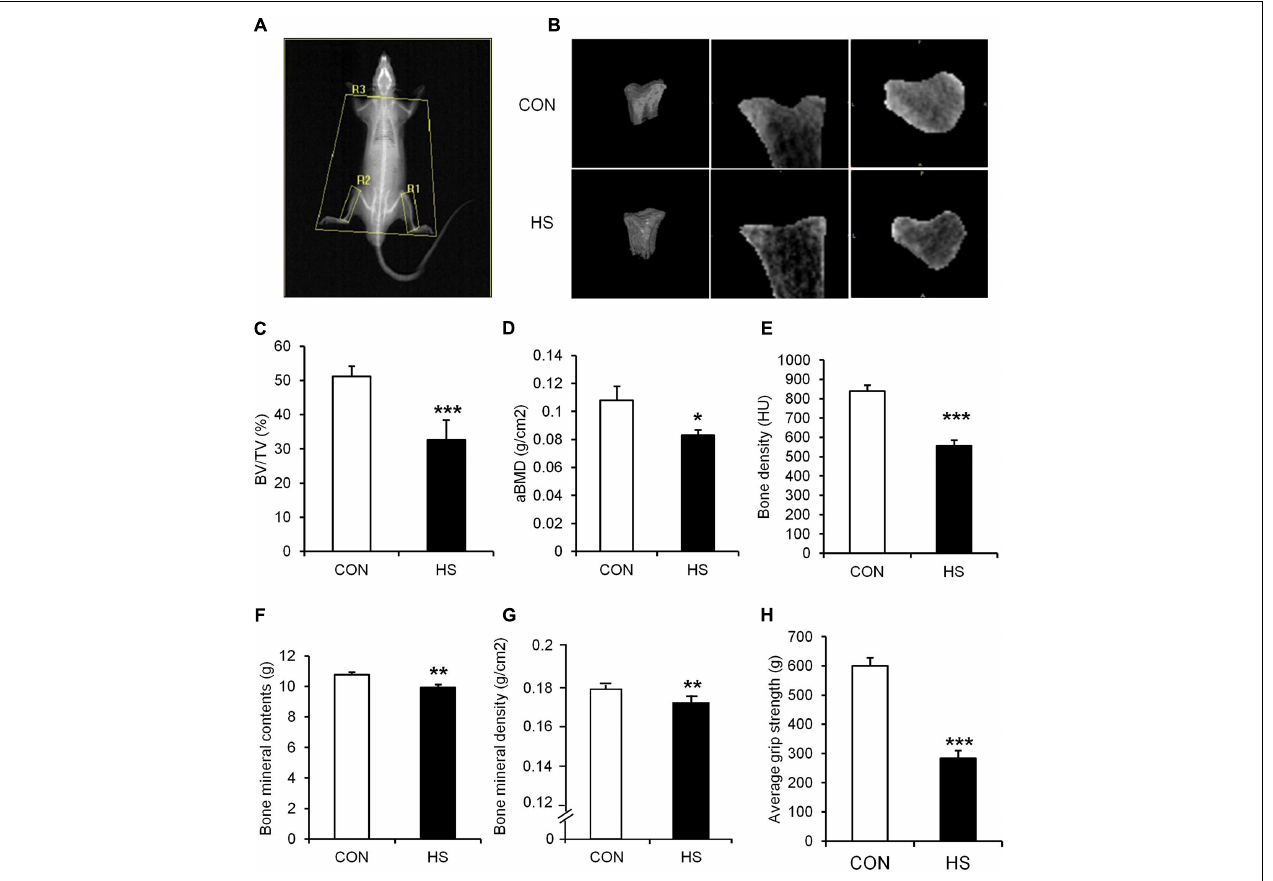
FIGURE 2 | The effects of hindlimb suspension on bone morphology and grip strength. (A) Image of ROI area selection of DXA scan (R1, right tibia; R2, left tibia; R3, whole body without head/global: whole body). (B) Representative micro-CT images of animals’ tibiae. (C) BV/TV, (D) aBMD, (E) bone density, (F) bone mineral contents, (G) bone mineral density, and (H) hindlimb grip strength were measured after 2-week hindlimb suspension. ∗ p < 0.05 vs. CON, ∗∗ p < 0.01 vs. CON, ∗∗∗ p < 0.001 vs. CON. All the results were presented as mean ± SE.